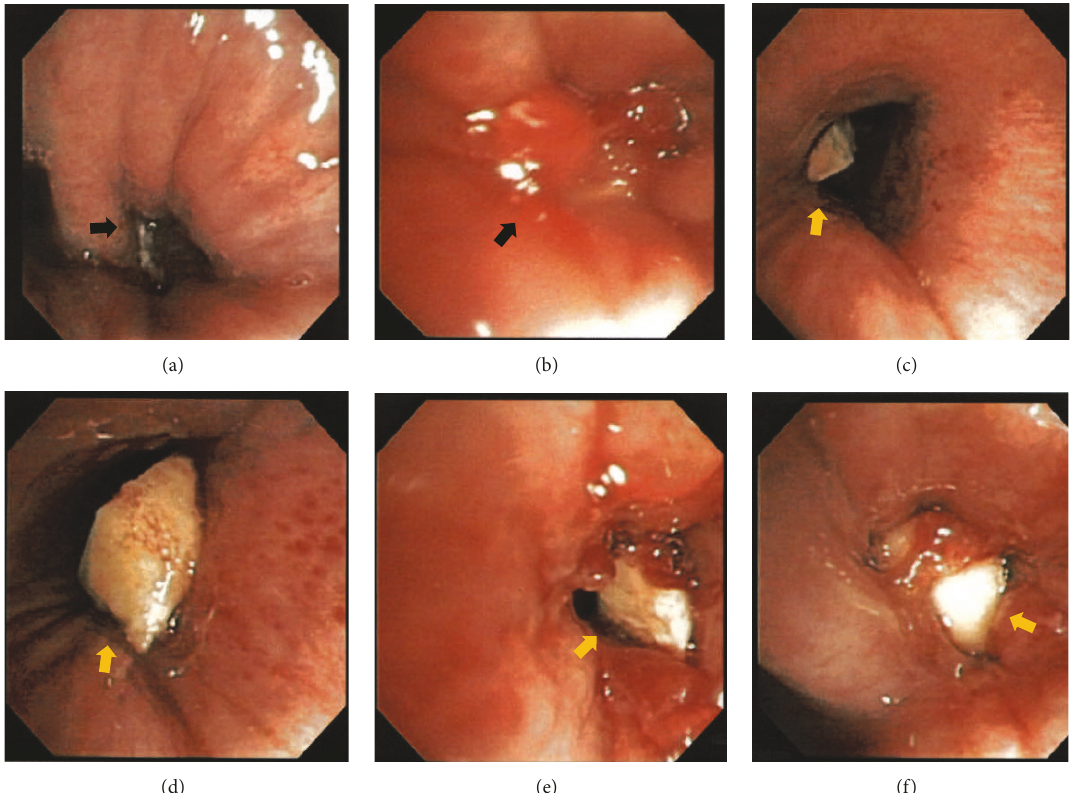
Figure 2: Bronchoscopic images ((a) and (b)) depicting an obstructed LLL bronchus with a fleshy, pearly endobronchial mass (black arrow). Bronchoscopic images of the almond (foreign body) in the left main stem and LLL bronchi [(c)-(f); yellow arrows].